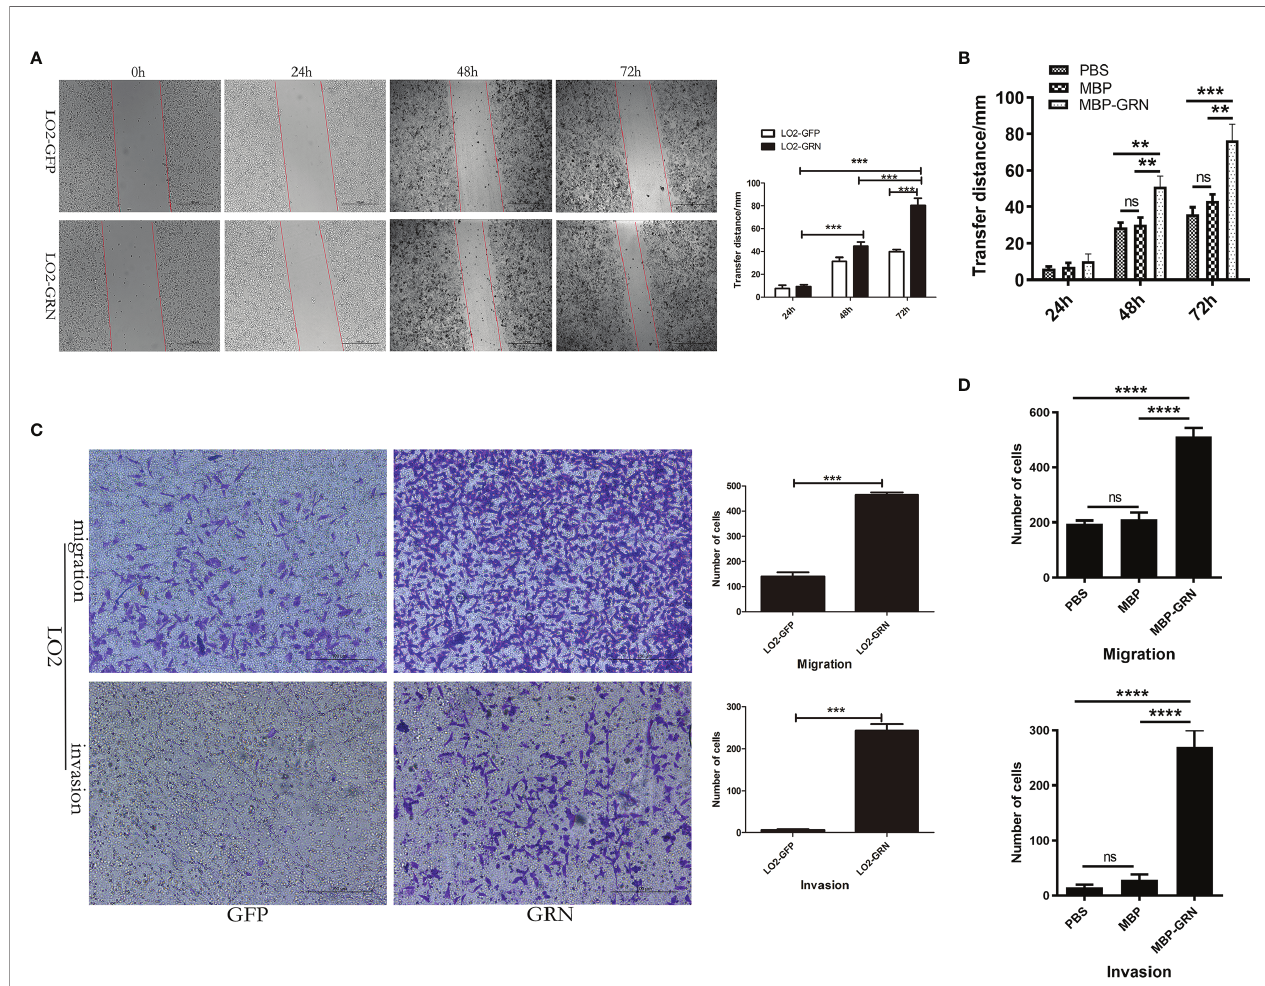
FIGURE 4 | The effects of migration and invasion in Cs GRN overexpression LO2 cells. (A, B) Wound healing scratch assay was used to determine the migration of Cs GRN-overexpressed LO2 cells (A) and recombinant Cs GRN protein – treated LO2 cells ( B ). Dotted lines show the edges of the wound over time. (C, D) Transwell assay was used to determine migration and invasion of Cs GRN-overexpressed LO2 cells (C) and recombinant Cs GRN protein – treated LO2 cells (D) . Ten random fi elds were selected, and the migration and invasion were quanti fi ed using Image J software. ** P < 0.01 versus control group, *** P < 0.001 versus control group, **** P < 0.0001 versus control